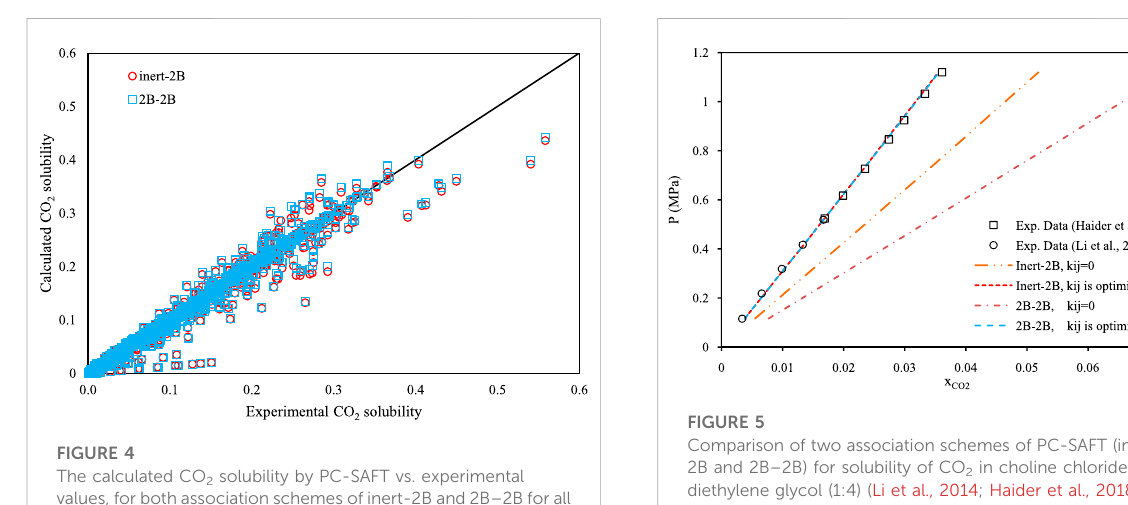
FIGURE 5 Comparison of two association schemes of PC-SAFT (inert- 2B and 2B – 2B) for solubility of CO 2 in choline chloride + diethylene glycol (1:4) (Li et al., 2014; Haider et al., 2018) at the temperature of 303.15 K. The pure component PC-SAFT parameters of the DES were optimized based on experimental density data (Li et al., 2014; Haider et al.,